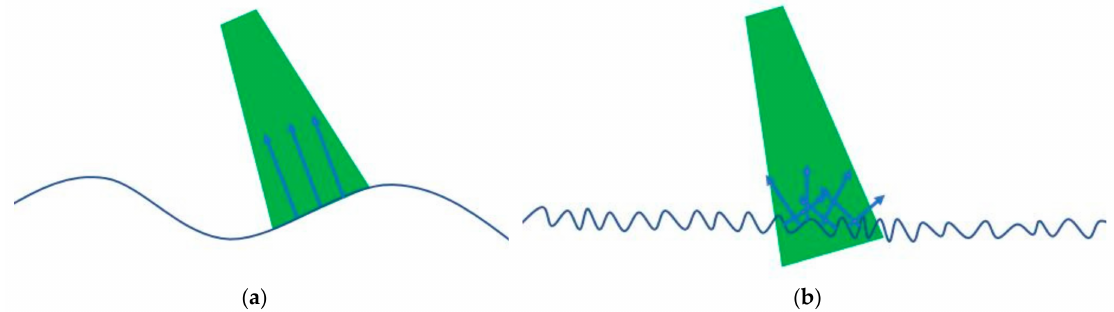
Figure 1. The schematic of laser beam interaction with ( a ) Gravity waves with wavelengths larger than the laser beam footprint; ( b ) Capillary waves with wavelengths smaller than the laser beam footprint. The arrows denote the surface normal of the wave